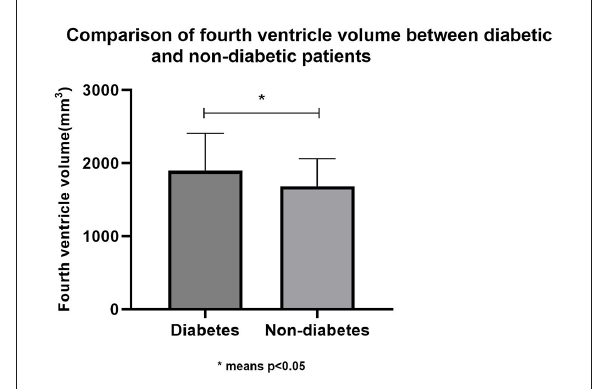
FIGURE2 Comparison of fourth ventricle volume between diabetic and non-diabetic patients. *means p < 0.05.